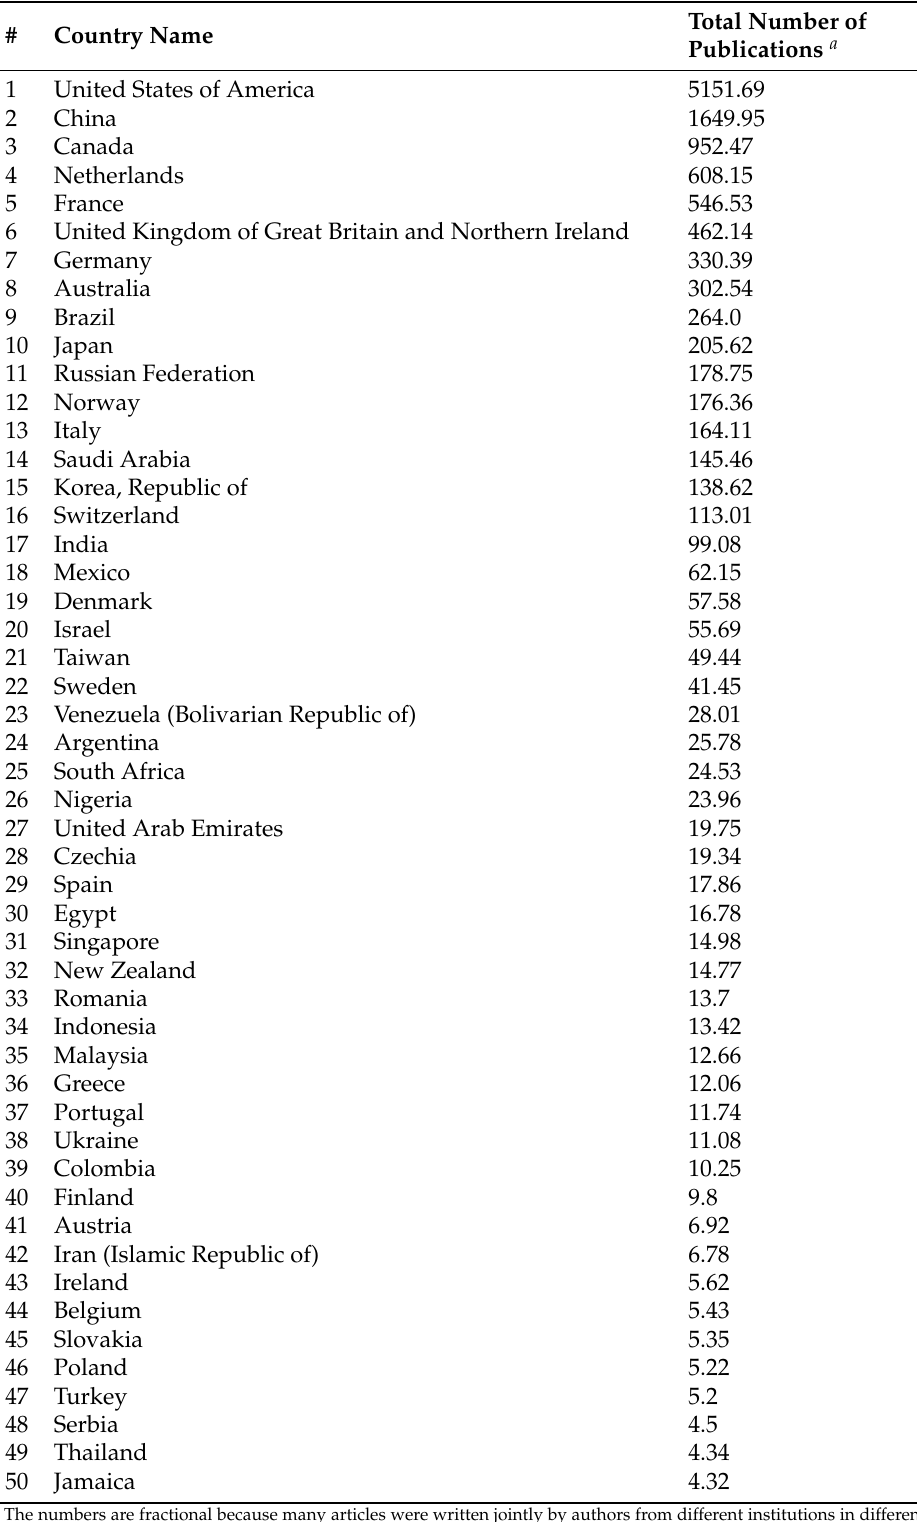
Table A1. The Total Number of Academic Publications by